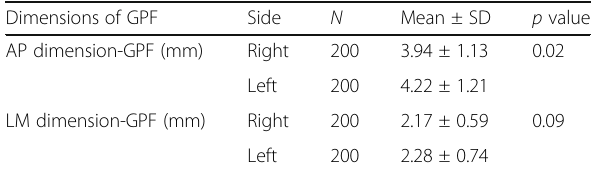
Table 5 The dimensions of the GPF based on side Dimensions of GPF